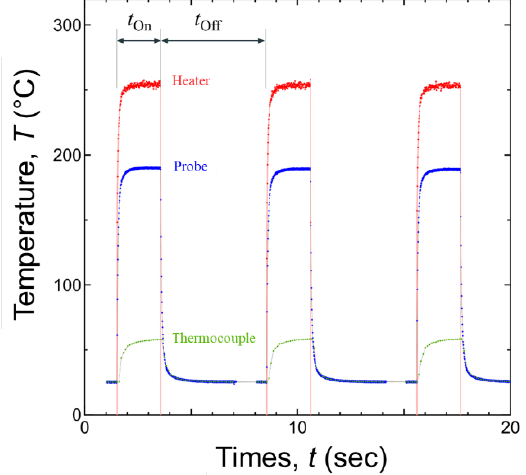
Figure 7. Temperature swing during power cycling tests.